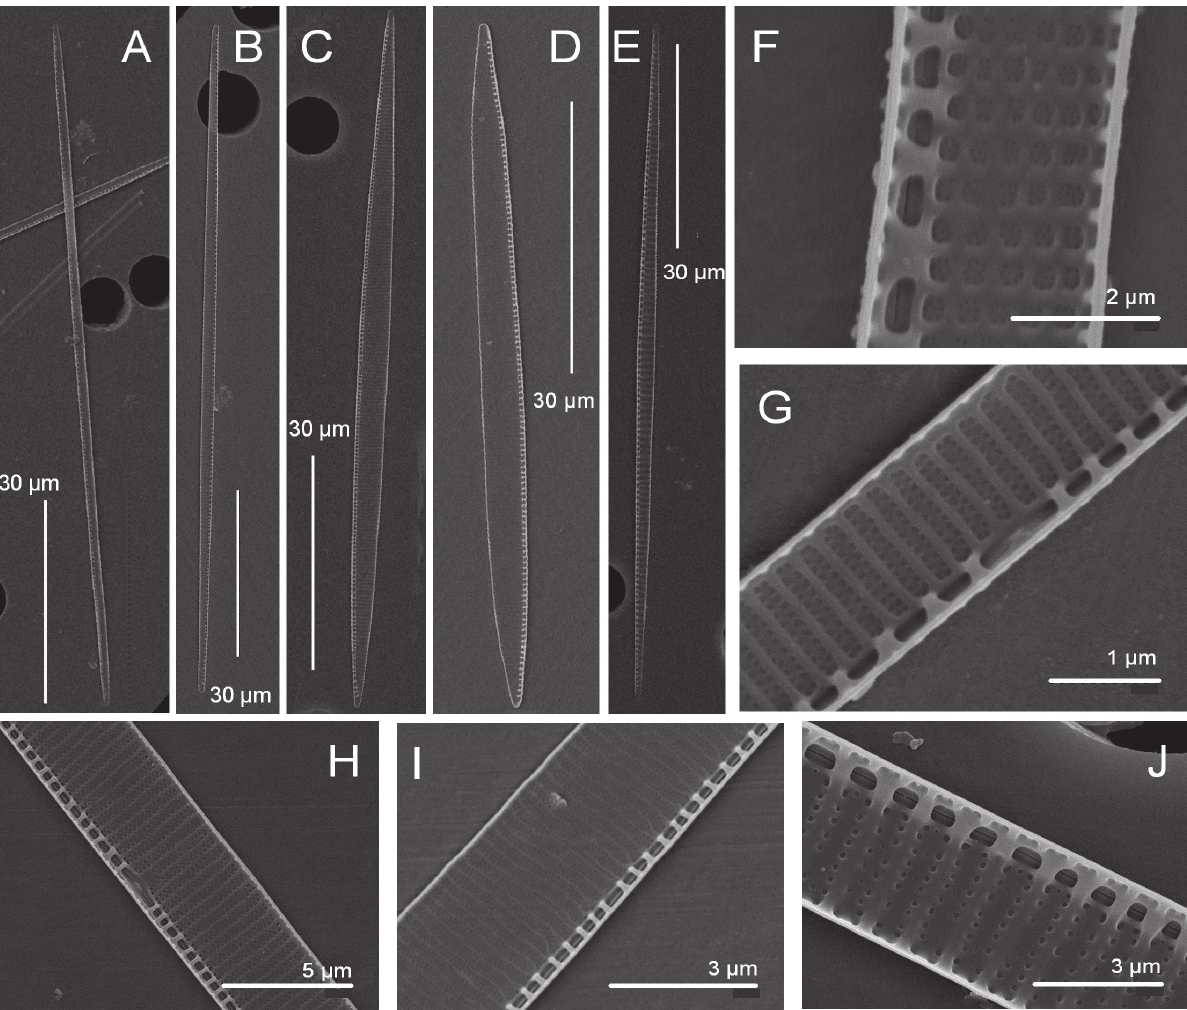
Fig . 2. – Scanning electron microscopy images of Pseudo-nitzschia species collected from the ebro delta. a, F, P. calliantha , B, g, P. deli- catissima , c, h, P. fraudulenta , d, i, P. multistriata , e, j, P. pungens